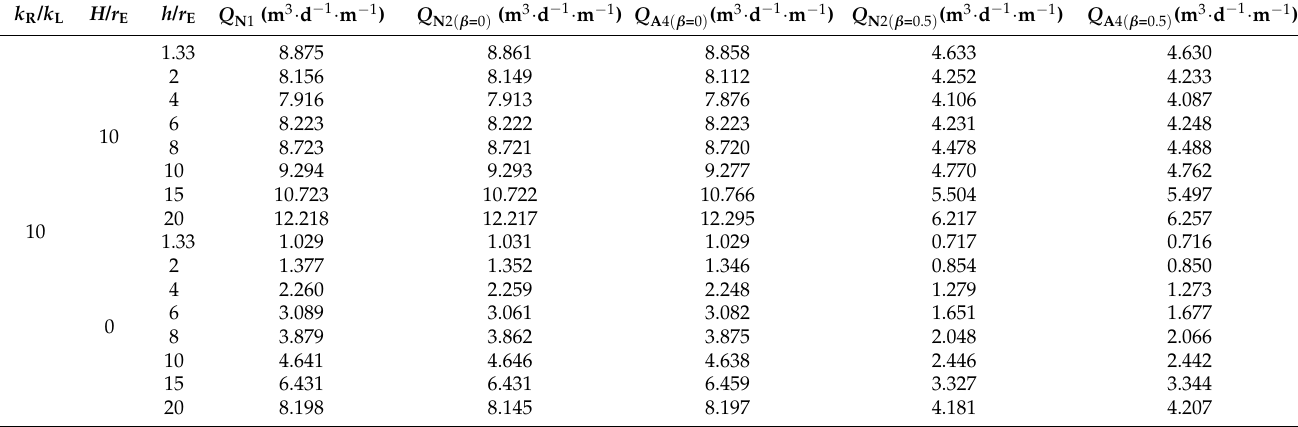
Table 3. Water inflow by numerical method and analytical